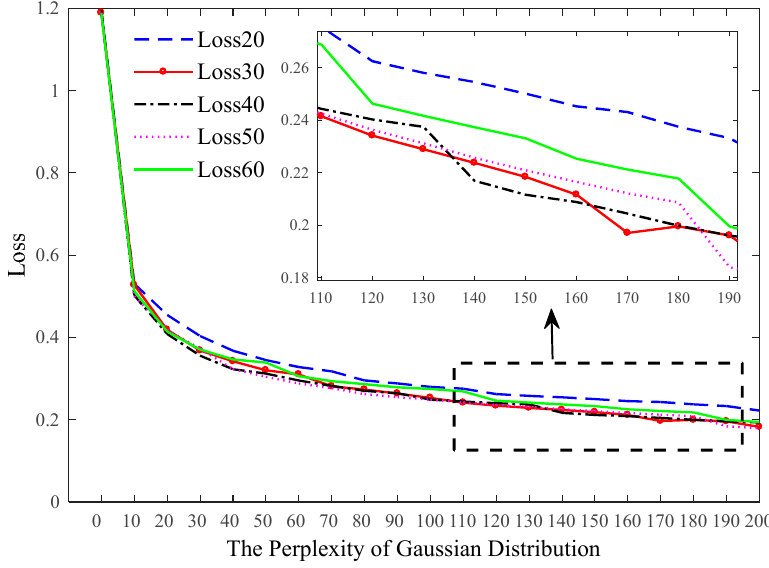
Figure 10. Loss curves at a different high R and perplexity values.